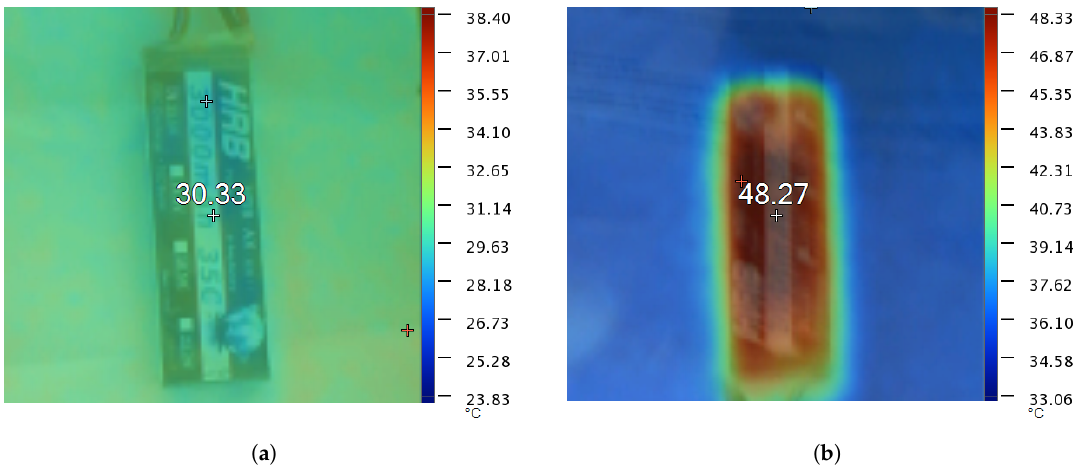
Figure 11. ( a ) Temperature of battery before flight; ( b ) temperature of battery after flight. Flight test 2—increase in battery temperature (cooled by contact with fuel stick, captured by thermal imaging device